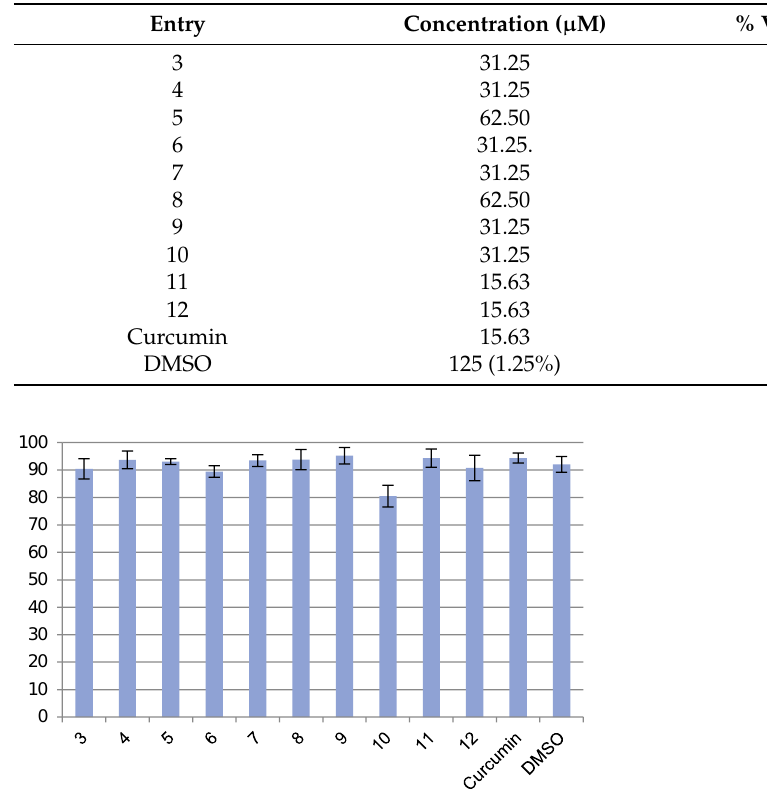
Table 2. The highest concentration of tested compounds that showed nontoxicity on SK-N-SH neuroblastoma cells.